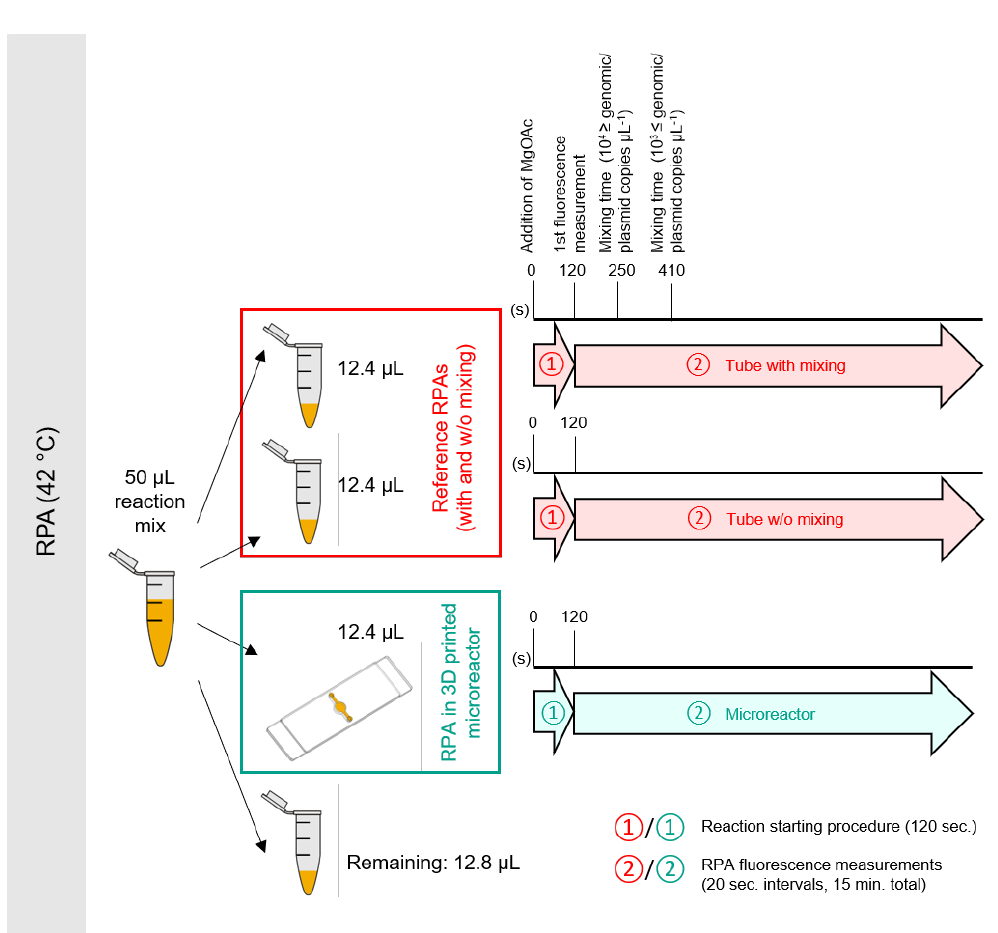
Figure 4. Distribution and incubation/mixing scheme for rtRPA reactions.